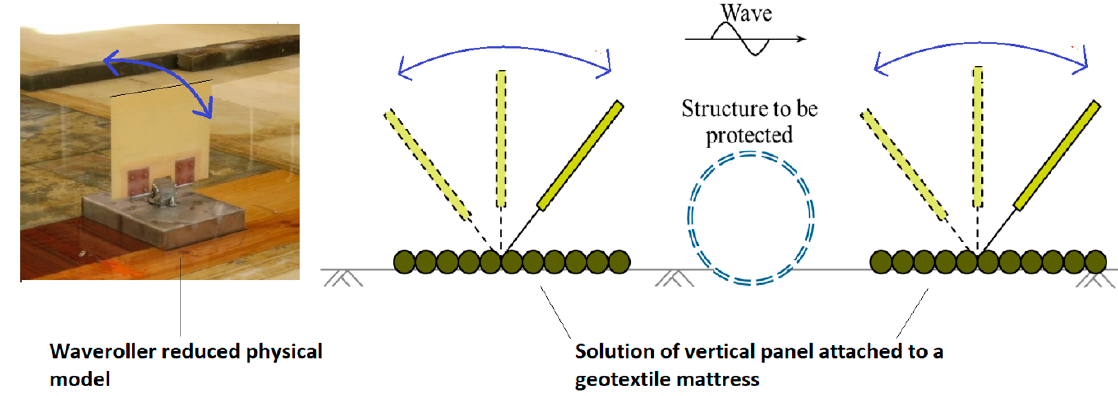
Figure 7. Scheme of the similar principle between the wave energy converter (WEC) WaveRoller from Reference [88] ( left ) and a vertical panel combined with geotextile mattresses from Reference [88] ( right ).